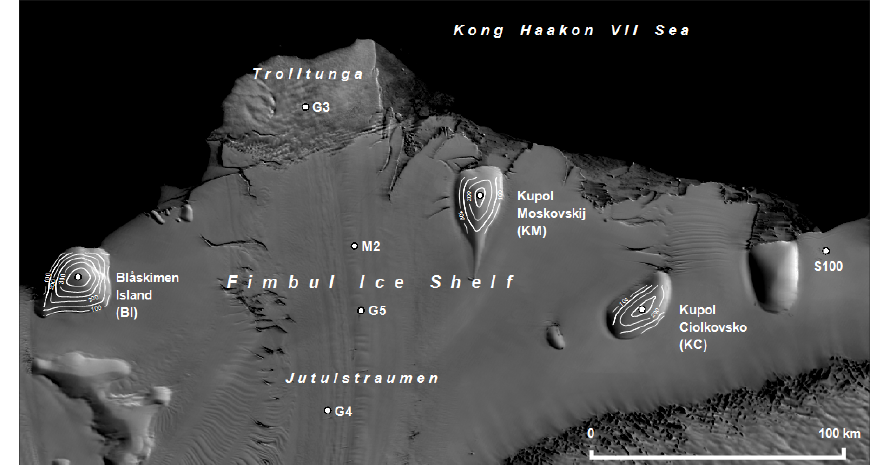
Figure 1. Satellite image of Fimbul Ice Shelf (FIS), East Antarctica showing the KC, KM, and BI core sites (this study), S100 (Kaczmarska et al., 2004), M2, G3, G4, and G5 core sites (Schlosser et al., 2014), Jutulstraumen and Trolltunga. In addition, 50m contours are shown at each ice rise, as derived from GPS profiles (V. Goel, personal communication, 2016). Map image is from the MODIS Mosaic of Antarctica (MOA). Information regarding additional sampling sites and traverses in FIS can be found in Schlosser et al.